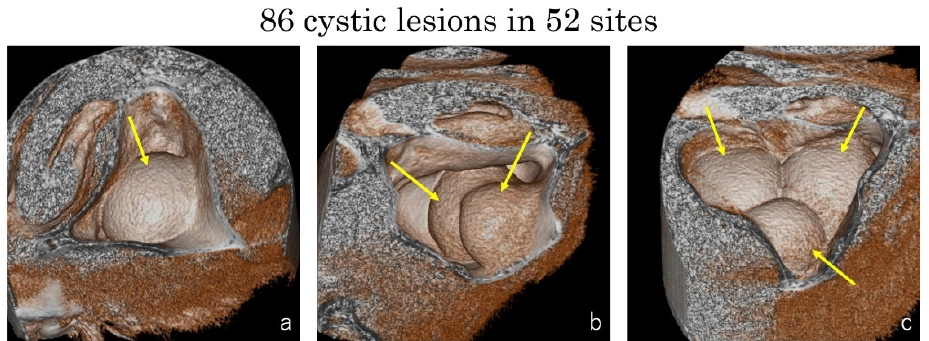
Figure 7. The numbers of cystic lesion in 52 sites were counted by the volume rendering images (yellow arrows). ( a ) One cyst in twenty-six sinuses (50%); ( b ) two cysts in twenty sinuses (38.5%); ( c ) three or more cysts in six sinuses (11.5%).